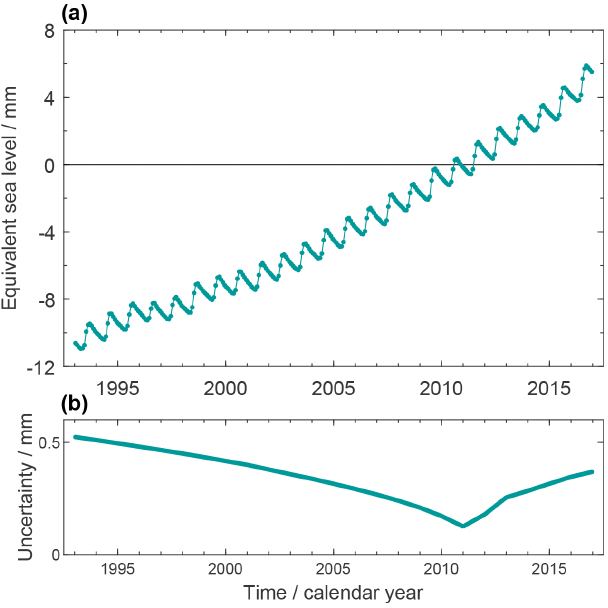
Figure 5. (a) Global glacier mass contribution to GMSL assessed by the GGM at a monthly resolution. Peripheral glaciers in Green- land and Antarctica are not included. Glacier mass change is ex- pressed in terms of equivalent GMSL change with respect to the mean of the reference interval of 2006–2015. (b) Uncertainties as- sessed for the estimates in (a)